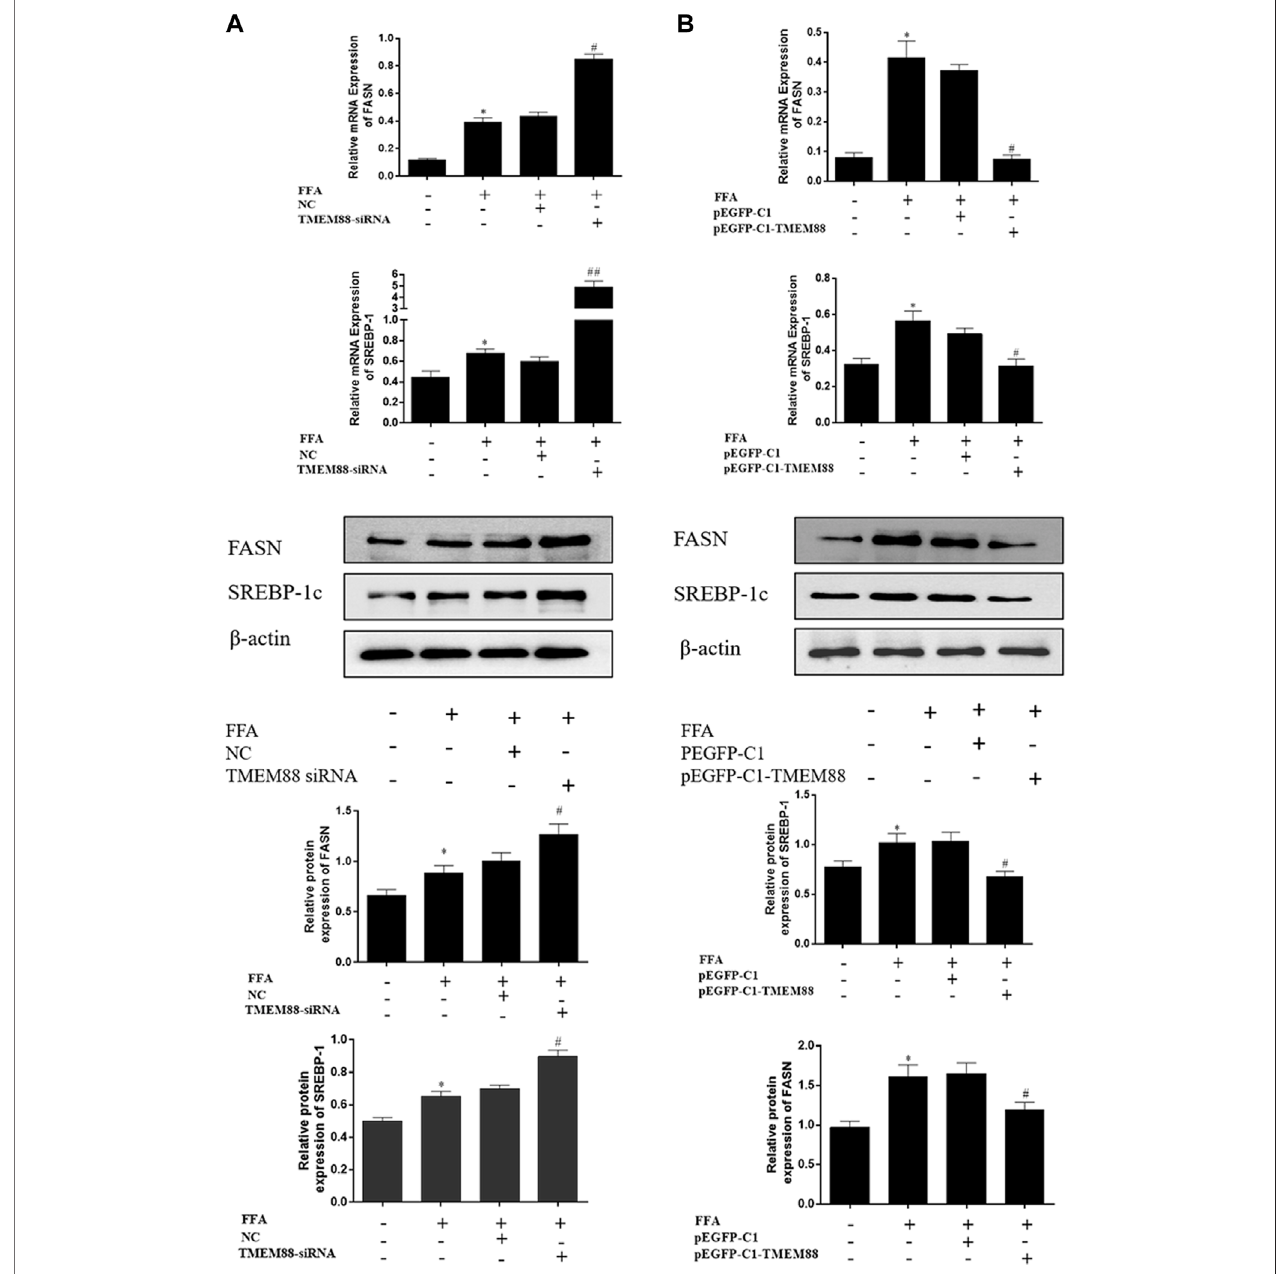
FIGURE 4 | Silencing or overexpression of TMEM88 regulated the lipid metabolism in FFA-induced AML-12 cells (A) When TMEM88 was overexpressed, the expression levels of FASN and SREBP-1c decreased. In contrast, (B) When TMEM88 was silenced, the expression levels of FASN and SREBP-1c were upregulated. (Data are represented by at least three independent mean ± SD, * p < 0.05 vs normal group, # p < 0.05, ## p < 0.01 vs control group).